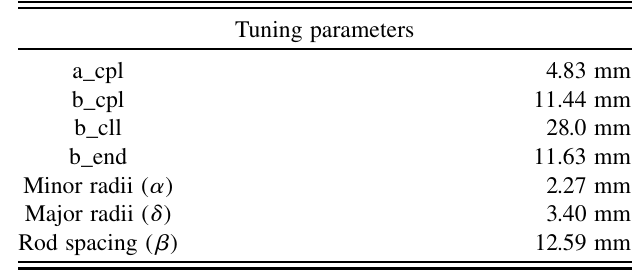
TABLE I. Fixed parameters for PBG-E structure. Final design values for Fig. 3(a).